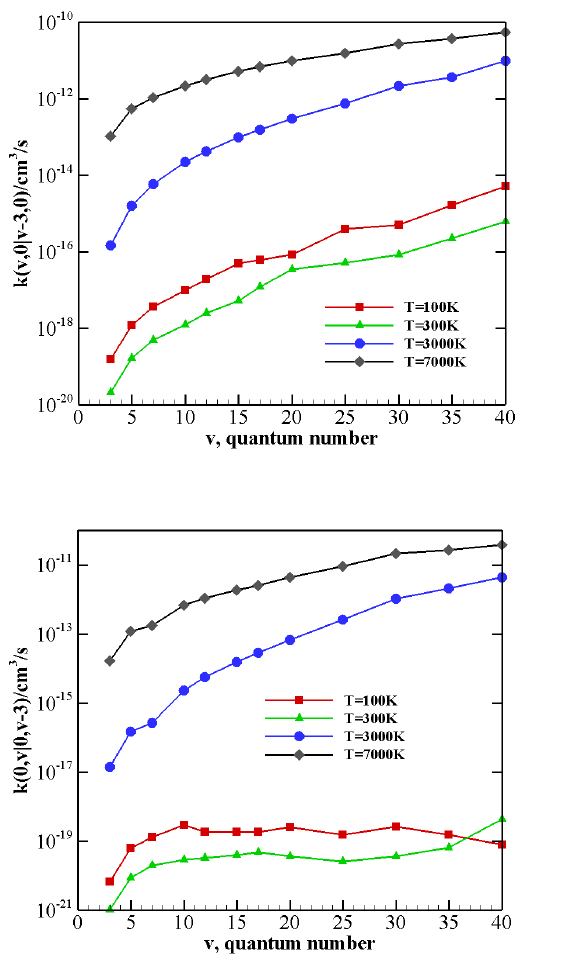
Figure 10. Multiquantum V–T/R rate coefficients as a function of the vibrational quantum number v at different temperature values for transitions ( upper panel ) CO ( v ) + N 2 ( 0 ) → CO ( v − 3 ) + N 2 ( 0 ) ; ( lower panel ) CO ( 0 ) + N 2 ( v ) → CO ( 0 ) + N 2 ( v − 3 )